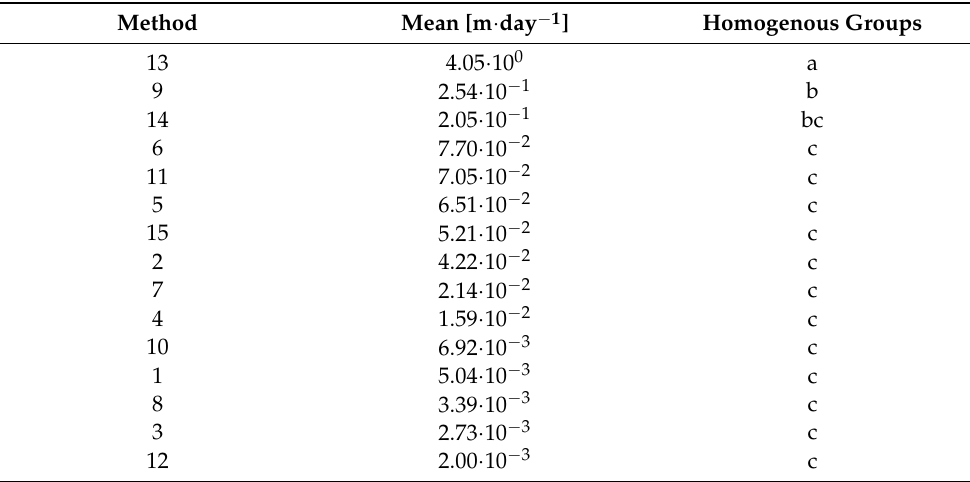
Table 5. Analysis of essential differences between results of determination by means of thepedotrans- fer functions.